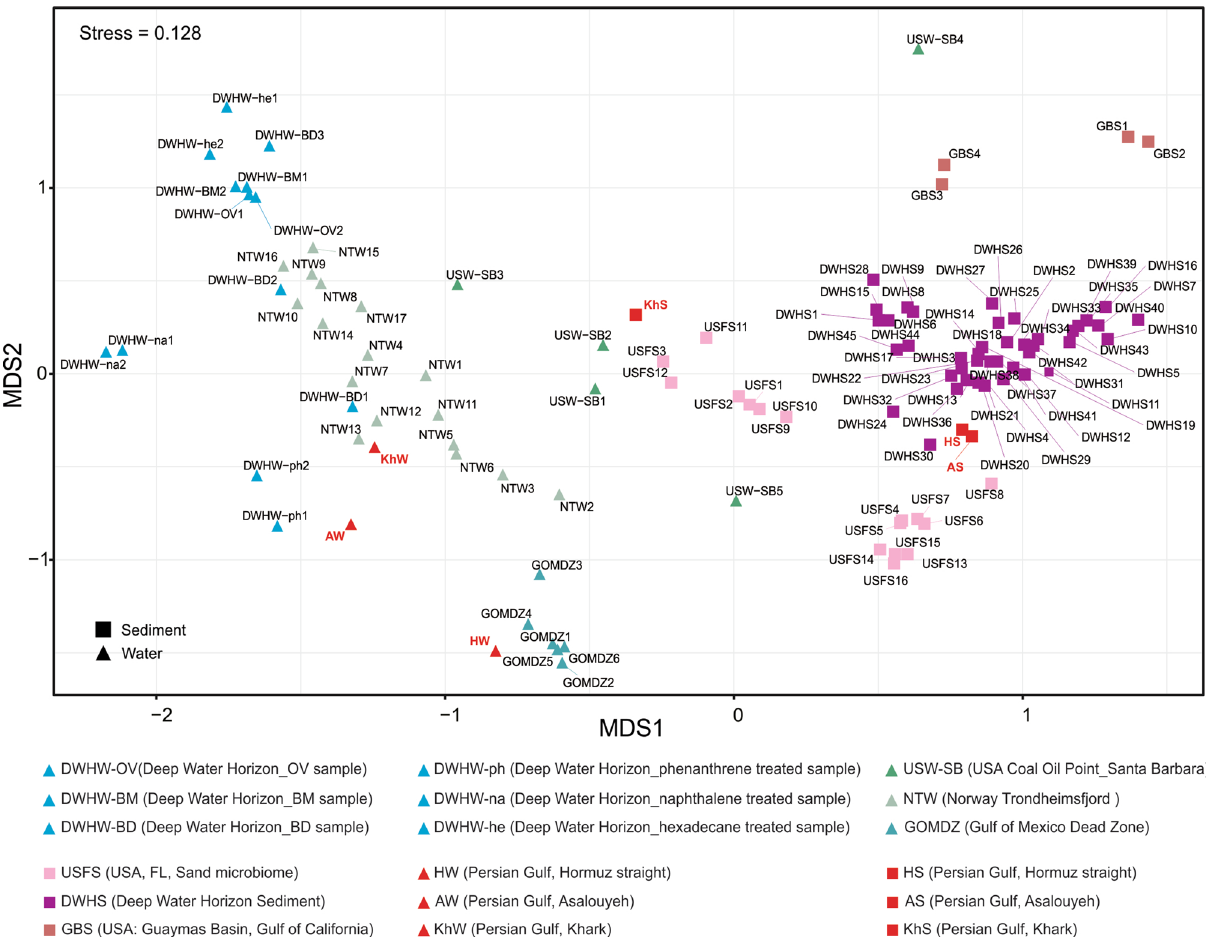
Figure 4. Non-metric multidimensional scaling (NMDS) of the Persian Gulf water and sediment metagenomes along with oil-polluted marine water and sediment metagenomes based on Bray–Curtis dissimilarity of the abundance of 16S rDNA reads in unassembled metagenomes at the order level. Samples with different geographical locations are shown in different colors. PG water and sediment samples are shown in red. Water and sediment samples are displayed by triangle and square shapes, respectively. Figure was plotted using “vegan” library in